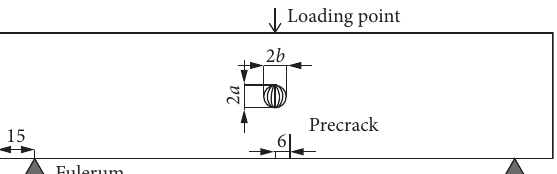
Figure 2: Schematic diagram of specimens.